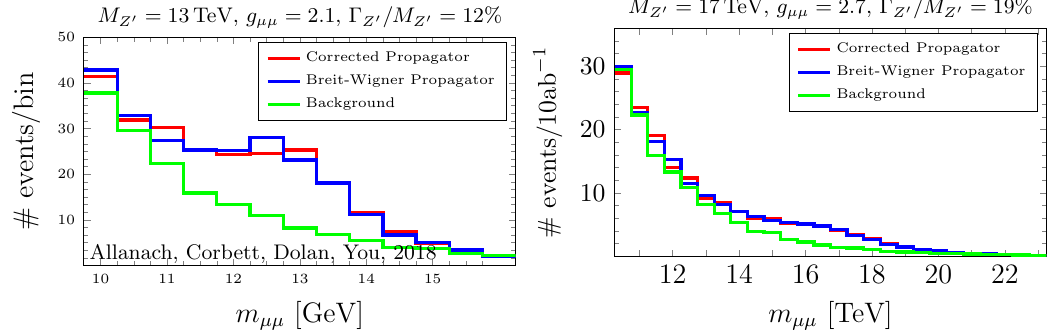
Figure 6 . Expected di-muon invariant mass distributions at the FCC for (left) M Z 0 =13 TeV, g (cid:22)(cid:22) = 2 : 1 and (right) M Z 0 =17 TeV, g (cid:22)(cid:22) = 2 : 7, corresponding to widths of 12% and 19% respectively. The expected number of events per bin on the ordinate is for 10 ab (cid:0) 1 of integrated luminosity. This (cid:12)gure shows the di(cid:11)erence between using the MadGraph5 default propagator and the new propagator (cid:24) 1 = ( p 2 (cid:0) M 2 (cid:0) ip 2 (cid:0) =M ). The signi(cid:12)cance for M z 0 = 13 TeV is 8.5 (9.7 for the default propagator) summing from bin 4 (5). The signi(cid:12)cance for M Z 0 = 17 TeV is 4.6 (5.6) summing from bin 9